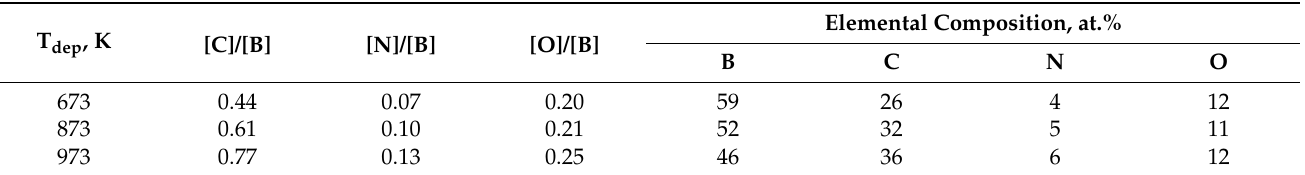
Table 2. Atomic ratios of elements and elemental composition of LPCVD BC x N y films from the XPS